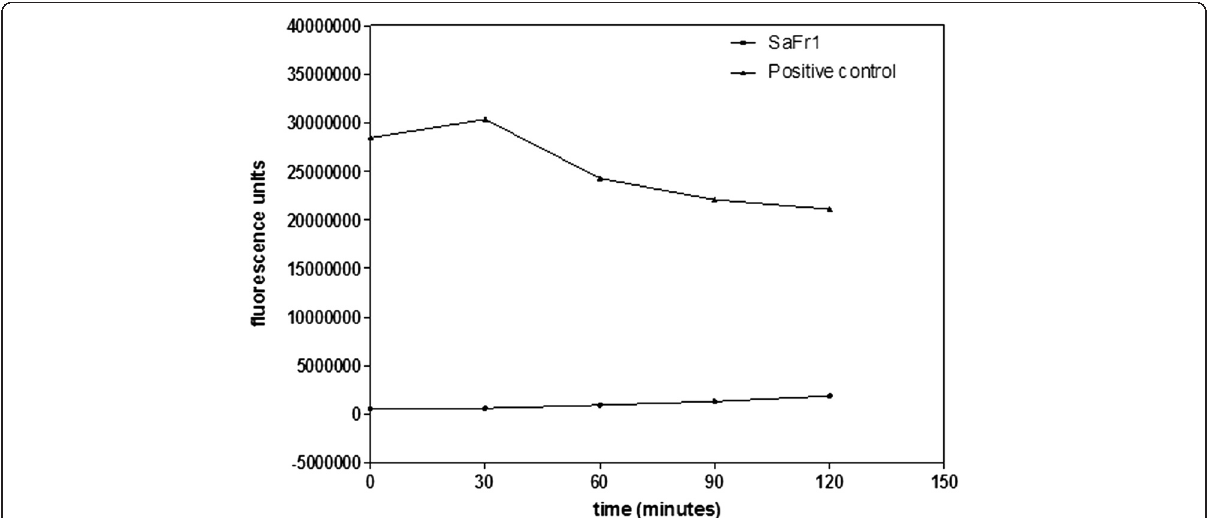
Figure 3 Evaluation of the plasma membrane permeability of L. (L.) infantum incubated with SaFr1 by SYTOX Green®. The fluorescence intensity was determined using a fluorimetric microplate reader with excitation and emission wavelengths of 485 and 520 nm, respectively. Triton X-100 was used as the positive control of the